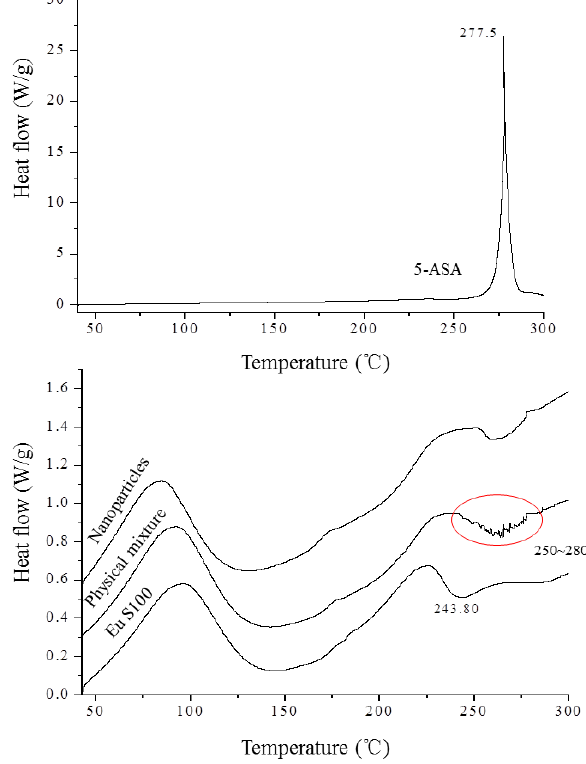
Figure 7. DSC thermograms of 5-ASA, EU S100, physical mixture and nanoparticles